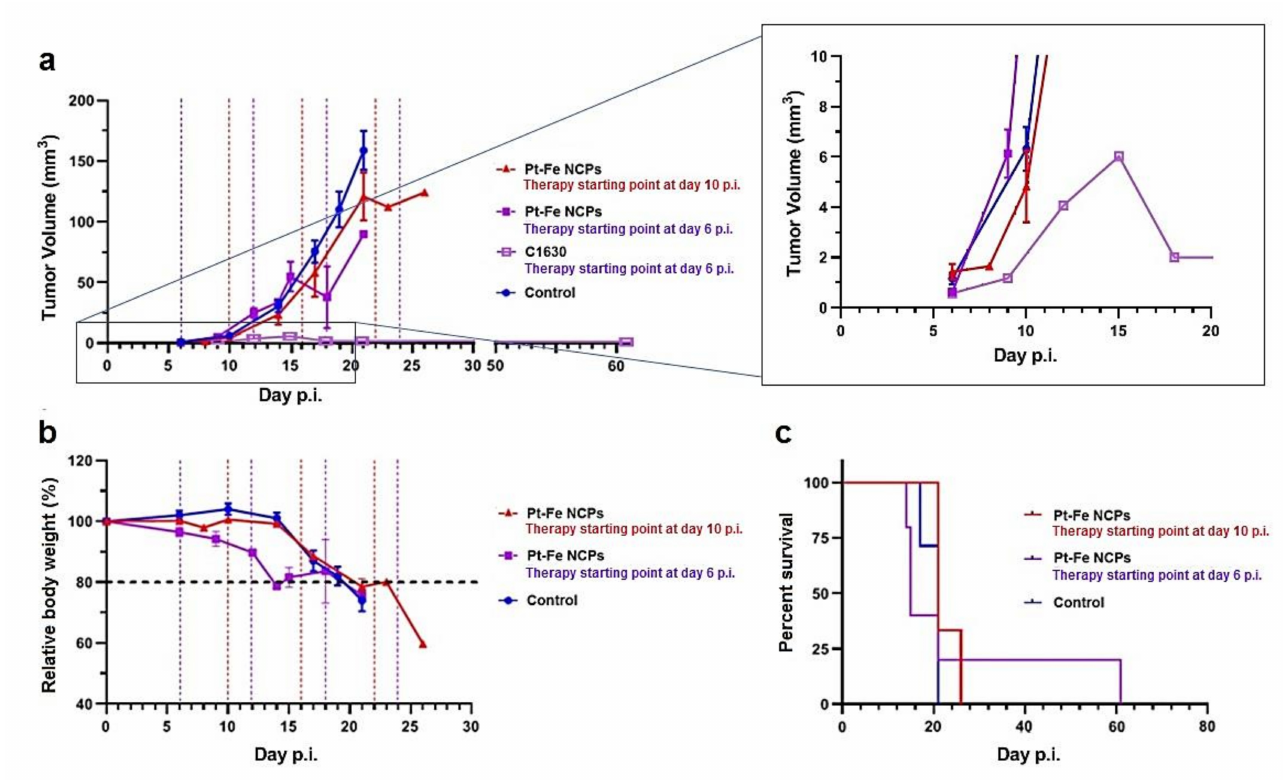
Figure 7. ( a ) Tumor volume evolution measured through T2w MRI. Note that a zoomed image of the case C1630 (cured case) in the period 0–20 days p.i. is shown apart on the right to ensure better visualization of the group evolution, ( b ) Mice relative body weight and ( c ) Kaplan–Meier survival curves for control mice ( n = 7, blue line), mice administered with Pt-Fe NCPs starting at day 10 p.i. ( n = 3, red line) and starting at day 6 p.i. ( n = 5, purple line). Note that graph in ( a ) shows mean values and it is restricted to 30 days for comparison purposes, without extending the graph to encompass the cured case. See Supplementary Figures S9 and S10 for checking evolution of C1630, the cured case in this